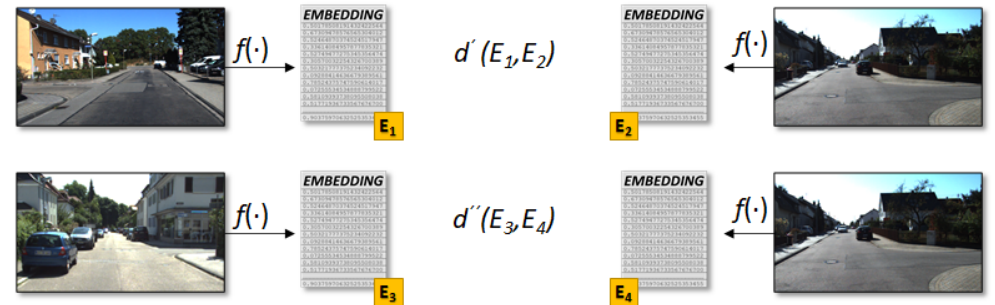
Figure 7. The distance between the two images is calculated using the numerical N-dimensional embeddings resulting from a generic DNN network. For example, considering the ResNet model, the resulting embedding E x dimension is 512. The intuition is that for different intersections the distance d (cid:48) between embeddings is larger than the distance of same-class intersection d (cid:48)(cid:48) . Triplet